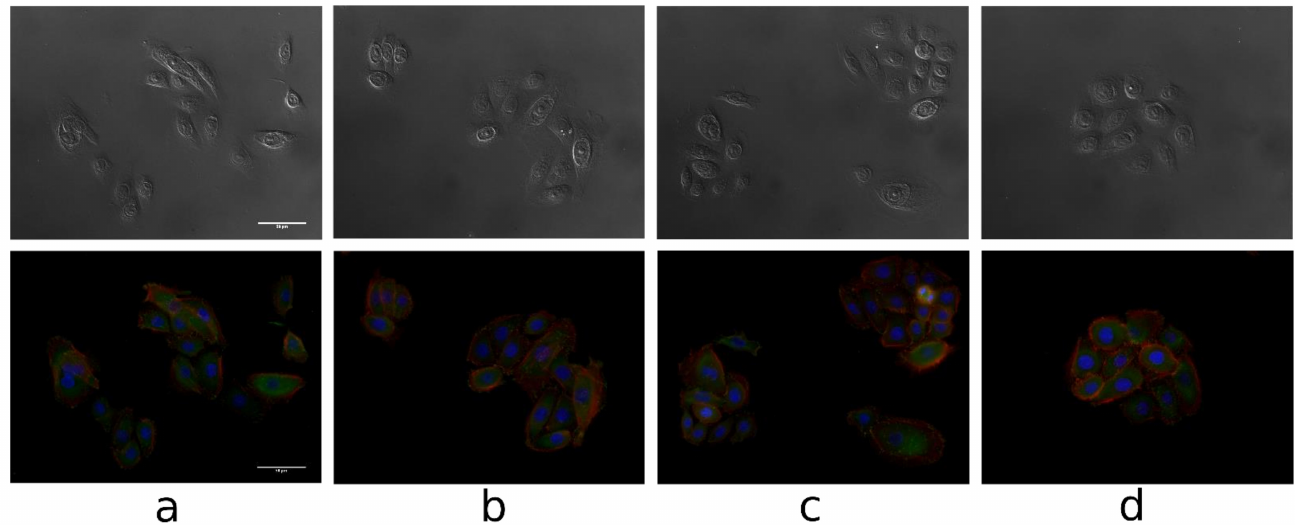
Figure 9. The fluorescence images of keratinocytes after 24 h of incubation with tested compounds (100 uM): control medium ( a ) lupeol acetate ( b ), lupeol isonicotinate ( c ) and lupeol acetylsalicylate ( d ). Scale bar = 500 µ m, red color—actin fibers, green color—vinculin, blue color—cell nuclei (Hoechst Stain